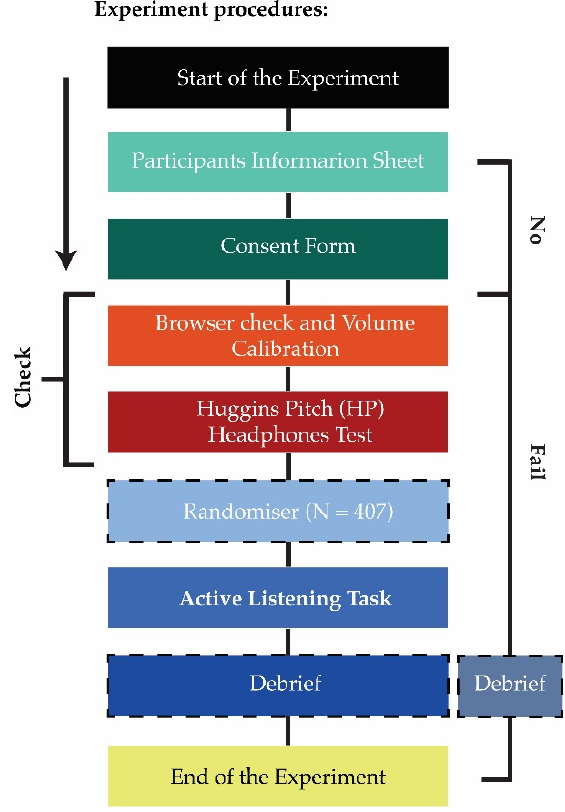
Figure 2. Progression of the online experiment in the Gorilla platform: only participants providing consent and passing both browser sound and headphone checks (highlighted with the black vertical line labelled “Check” on left) would begin the active listening experiment. If the participants did not read the information sheet, would not consent, or failed the browser, volume calibration or Huggins Pitch (HP) headphones test, they were debriefed and directed to the end of the experiment (highlighted with the black vertical line on the right).